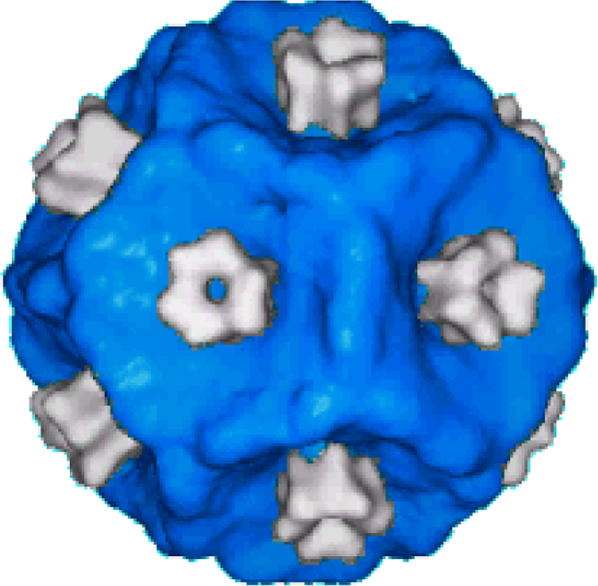
RNA phage viruses that co-infect host cells with more fit viruses can withstand high mutation loads with the help of their fitter counterparts—but only for so long